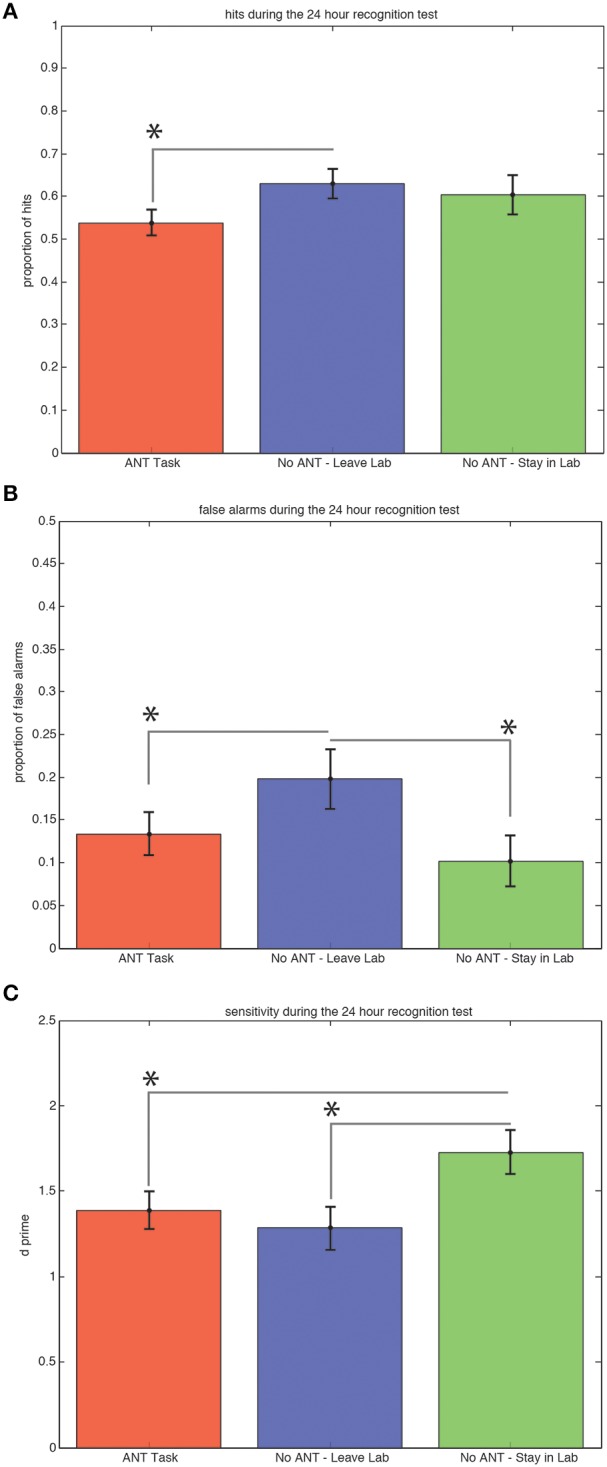
Ability to Discriminate Old from New Scenes at the 24 h Recognition Test is Better for Subjects Who Remained in the Same Context and Rested Quietly. Average hits (± SEM) are significantly lower for the group that performed the R-ANT task (A). Subjects who left the testing room made significantly (*p < 0.05) more false alarms (B) compared to subjects who performed the R-ANT task and subjects who remained in the testing room and rested quietly. Subjects who stayed in the testing room and rested quietly showed significantly higher sensitivity compared to the subjects who performed the attention task and those who changed spatial context by leaving the testing room during the 30-min post-exposure period (C).